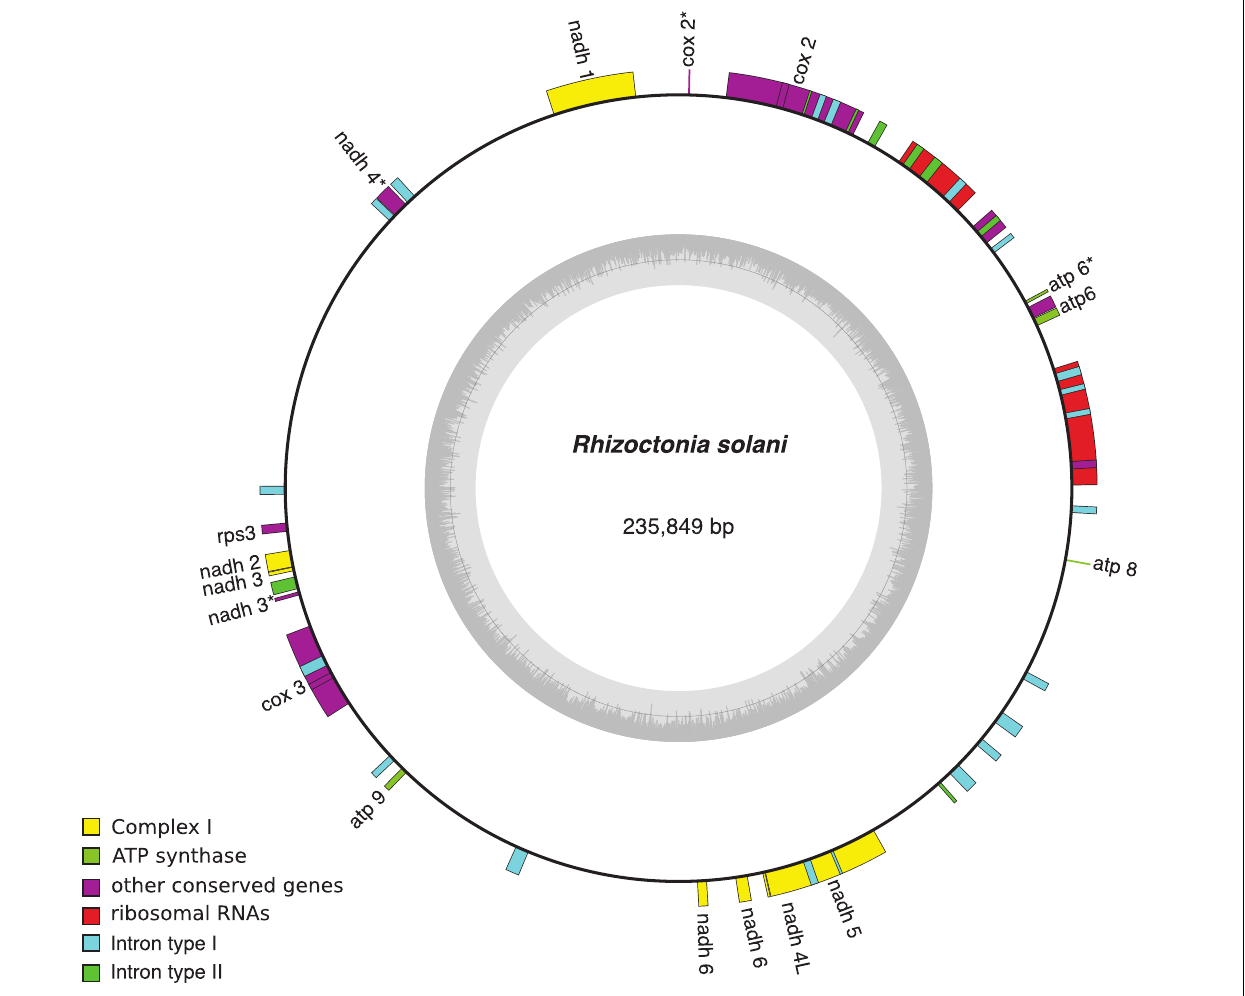
FIGURE 3 | Rhizoctonia solani mitochondrial genome and the type and number of introns present. The complete mt-genome is 235,849 bp long and encodes 15 conserved genes (showed in yellow). Group I introns are in red whereas group II are in blue. NCBI Reference Sequence: NC_021436.1. Figure was made using